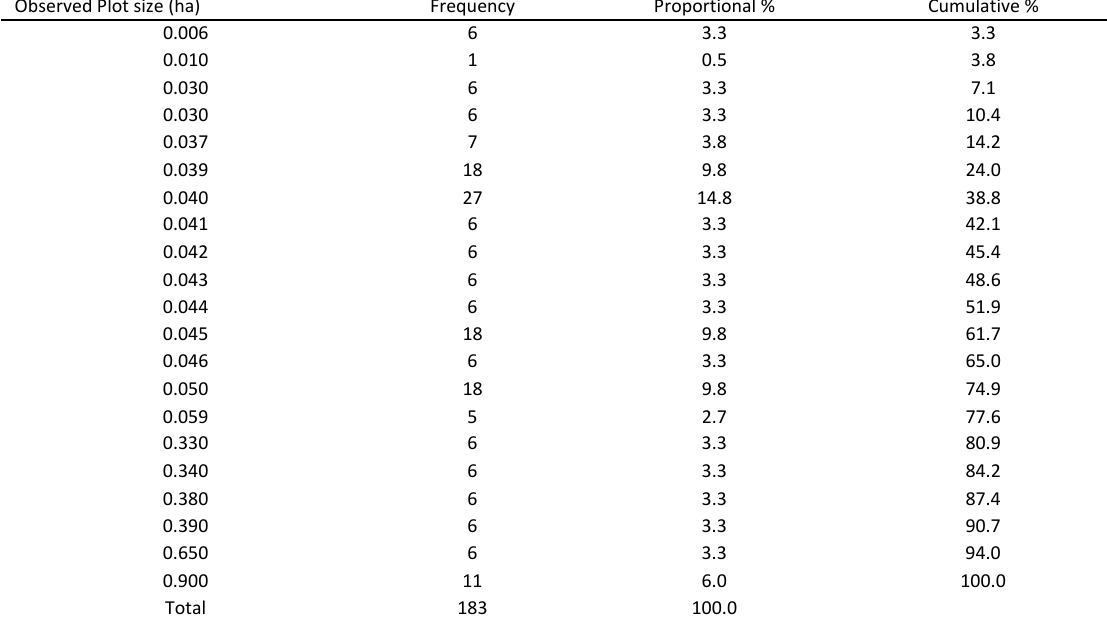
Table 8: Case by case grouping of observed compliance with subdivisions Observed Plot size (ha)